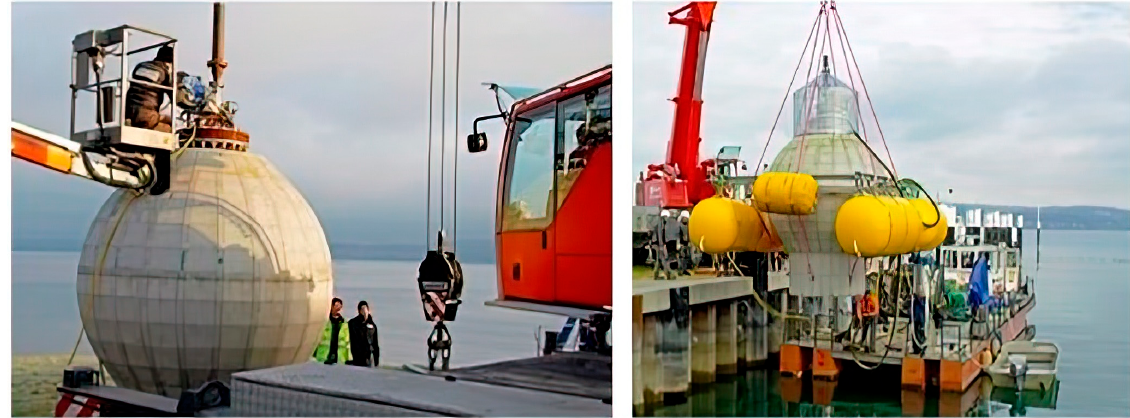
Figure 7. Lake Constance offshore pumped storage experiment in 2017 [53].